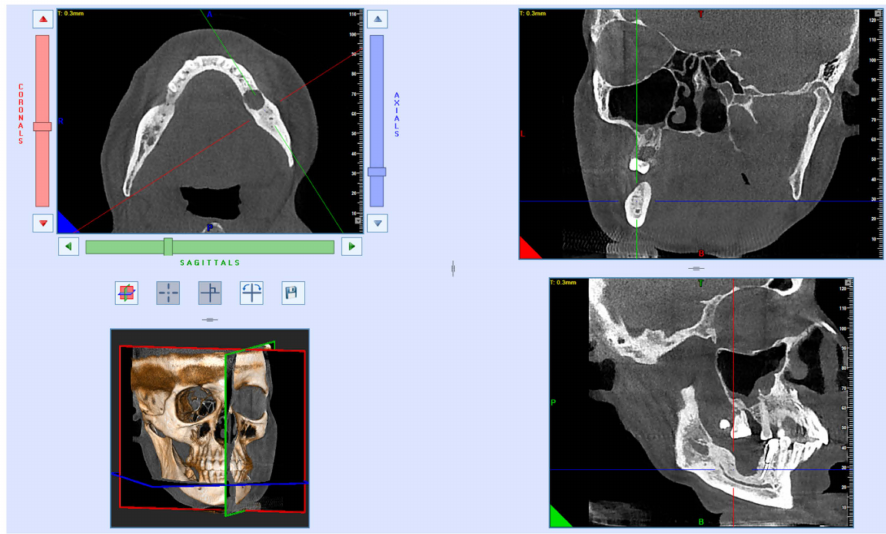
Figure 5. CT scan after dental implant loss before bone plasty 7 years after